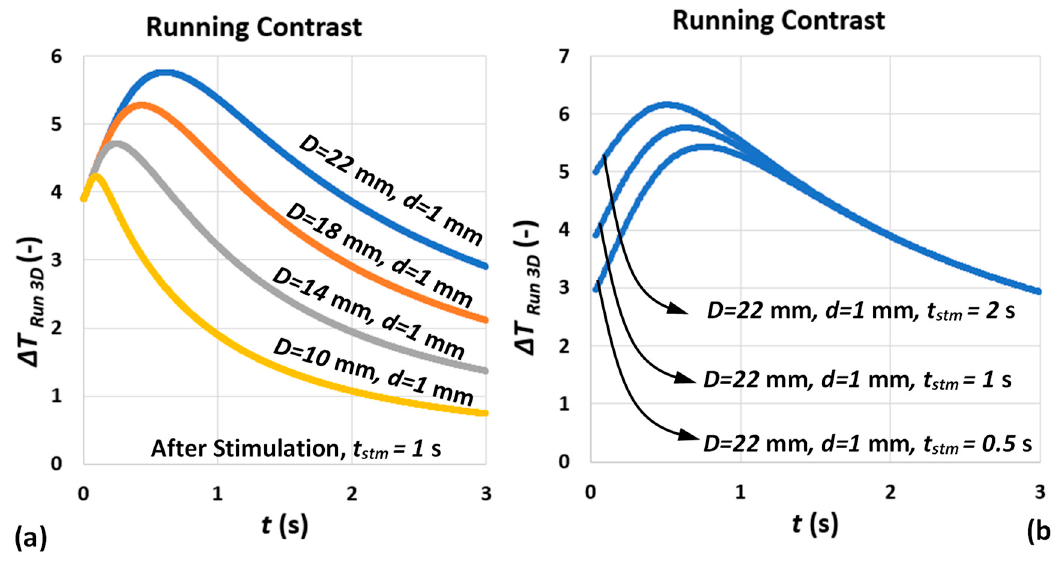
Figure 10. ( a ) Analytical (3D) running contrast defects for various diameter, D , on an L = 8 mm thickness mild steel specimen subjected to a square-pulse stimulation of duration t stm = 1 s. ( b ) Analytical (3D) running contrast of a defect with diameter D = 22 mm and d = 1 mm on an L = 8 mm thickness mild steel sample subjected to square-pulse stimulation of duration t stm = 0.5, 1 and 2 s. The pulse-absorbed power density is assumed Q = 10 kW/m 2